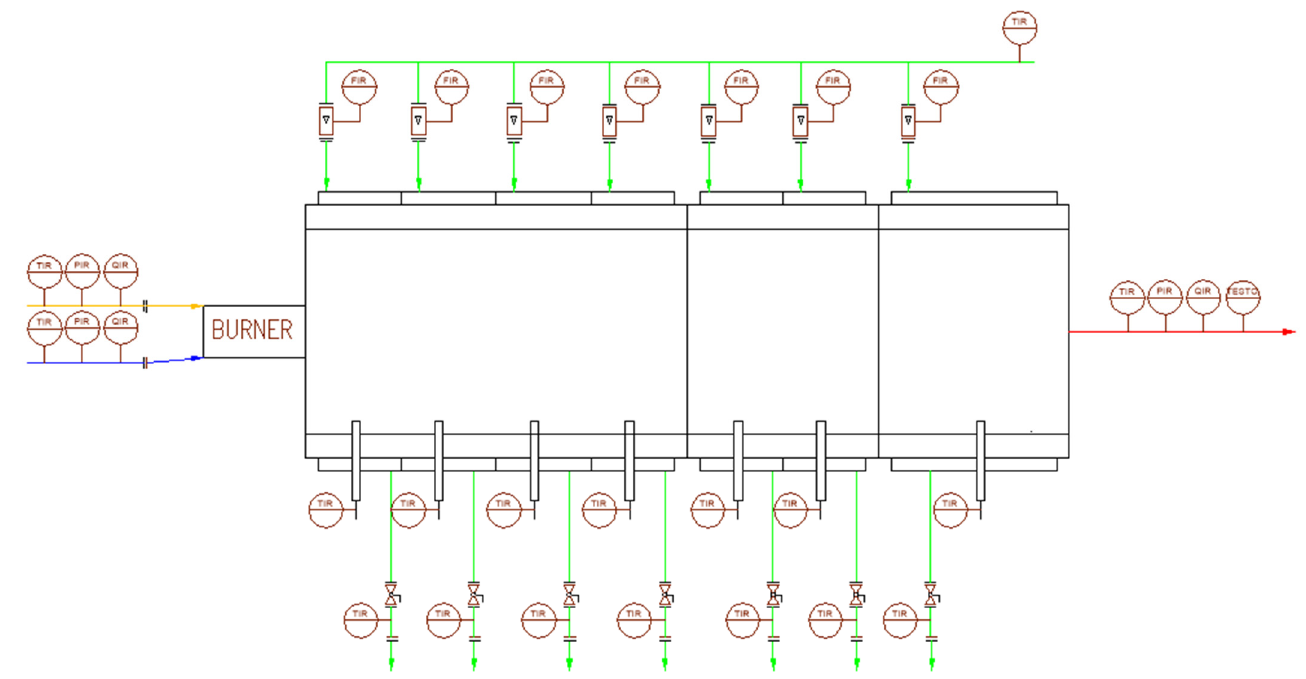
Figure 5. The technological scheme of the combustion chamber. Figure 5. Model of low-calorific burner designed after the first experiments (denoted as Burner C). TEST B was focused on the flame temperature. For this test, R-type thermocouples were used to measure the temperature in the horizontal plane of the flame. In total, eight R-type thermocouples were used to cover the temperatures along the horizontal plane of symmetry. Measuring points were located 50 cm from each other along the whole com- bustion chamber. Each thermocouple was connected to the Graphtec midi LOGGER GL220, which recorded the measured values. Temperatures were measured at six differ- ent positions: near the wall (5 cm), 10, 20, 30, 40, and 50 cm from the wall. TEST C was focused on measurements of heat flux into the wall of the combustion chamber. This was allowed due to the unique construction of the combustion chamber, divided into seven different sections and equipped with thermocouples and flowmeters to measure cooling water properties to calculate the overall heat flux. During TEST A, limits (both in design and technological) for each burner were re- vealed. Thus, for TEST B and TEST C, only a few different fuel compositions were selected, which were adjusted according to the results obtained during TEST A and to obtain data describing the trend without unnecessary waste of the fuel. Before each test, conditions in the combustion were stabilized; it was vital to control the flow rate of fuel and combustion air to achieve stable conditions. Although measurements were conducted in exact inter- vals, maximum effort was used to ensure the repeatability and accuracy of each test. 3. Results 3.1. TEST A—Emissions, Flame Stability, Flue Gas Temperature The experiments with Burner A revealed that the construction of this burner is not sufficient for a dilution higher than 10 m N3 /h (LHV 28.67 MJ/m 3 ) of CO 2 and 20 m N3 /h (LHV 24.58 MJ/m 3 ) of N 2 , as is evident from the experimental matrix for TEST A (Table 2). The limitation was that the burner head, originally designed for noble fuels, could not distrib- ute more fuel. It was evident that it would be possible to achieve a higher flow rate with higher overpressure of fuel, but this change would affect the comparison of the results. Even though the amount of the added inert gases was low and the reduction of NO x in the flue gas was lower, it was possible to observe signs of dependence. The difference between the effect of N 2 and CO 2 is also evident. CO 2 as a larger molecule can absorb much